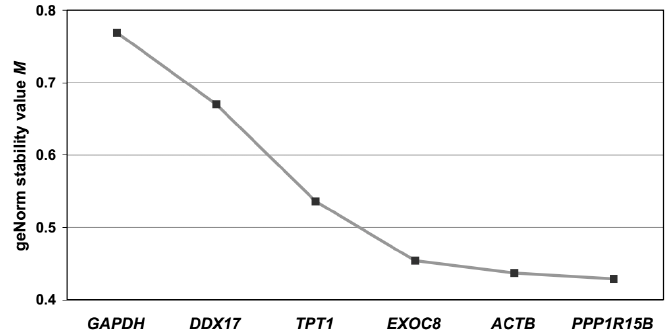
Figure 6. Average expression stability values ( M ) in the entire set of maternal blood samples. M is calculated using geNorm and the remaining control genes during stepwise exclusion of the least stable control gene. The gene with the lowest M has the most stable expression.